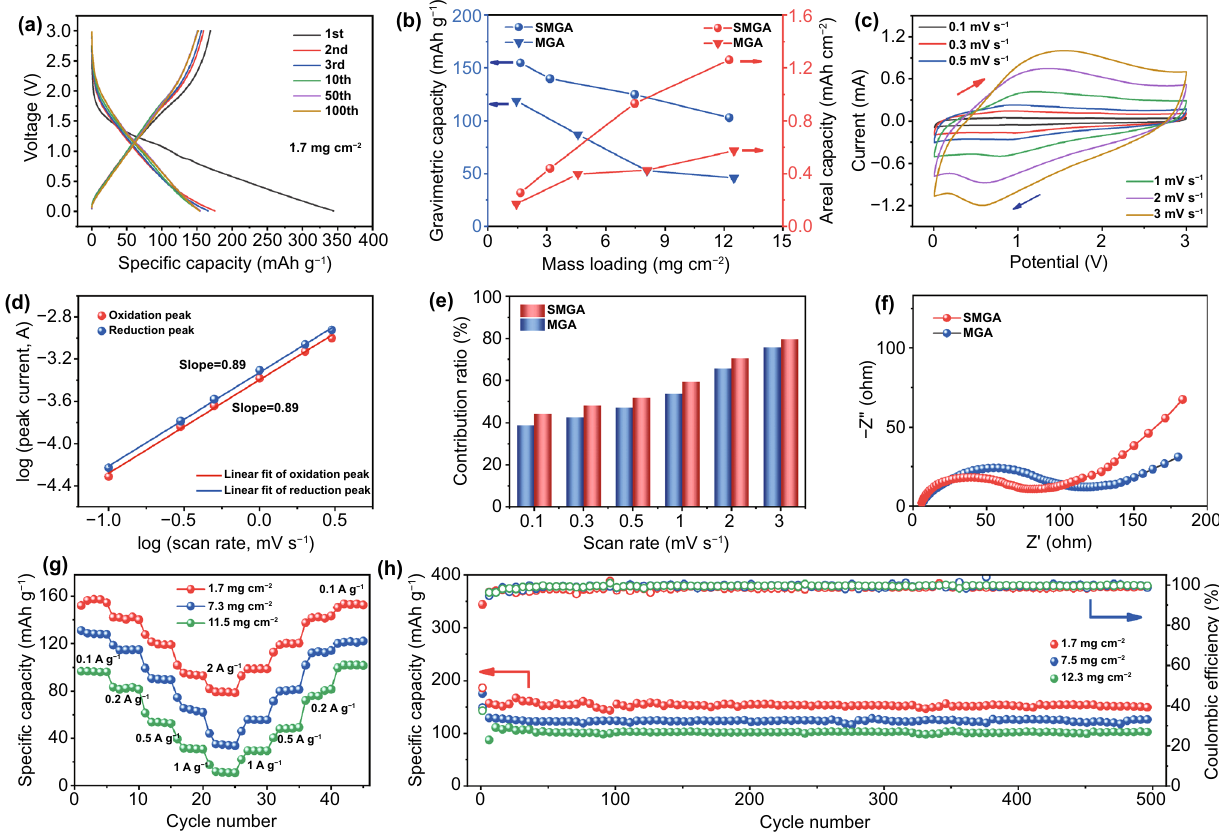
Fig. 5 Half-cell tests of the freestanding SMGA and MGA electrodes for electrochemical sodium-ion storage. a Galvanostatic charge–discharge profiles of SMGA at 100 mA g −1 . b Gravimetric and areal capacities of SMGA and MGA with different areal densities at 100 mA g −1 . c CV curves of the SMGA electrode at different scan rates from 0.1 to 3 mV s −1 . d Relationship between the peak current and scan rate for the SMGA electrode. e Capacitance contributions of SMGA and MGA at different scan rates. f Nyquist plots of SMGA and MGA in Na-ion half-cell. g Rate performances of the SMGA electrodes with different mass loadings at rates ranging from 0.1 to 5 A g −1 . h Cycling performances and Cou- lombic efficiencies of the SMGA electrodes with different mass loadings at a current density of 0.1 A g